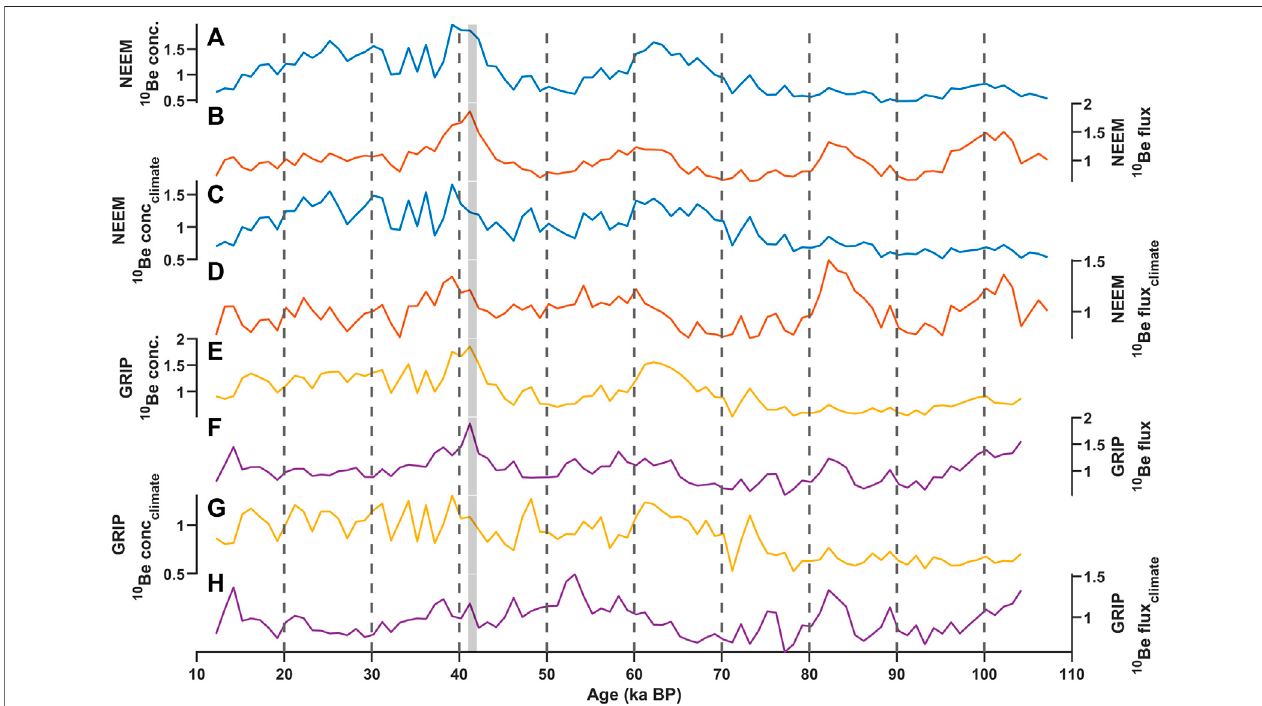
FIGURE 1 | 10 Be records of NEEM ice core showing concentrations (A) , fl uxes (B) and the corrected records for geomagnetic modulation referred to as 10 Be conc climate (C) and 10 Be fl ux climate (D)(E – H) thesamefortherecordfromtheGRIP icecore.Thegrey barshowsthepeakduetotheLaschamps geomagneticexcursion during 41 – 42 ka BP. All data are resampled at a 1000-years resolution for the analysis (see text) and normalized for the overlap period.